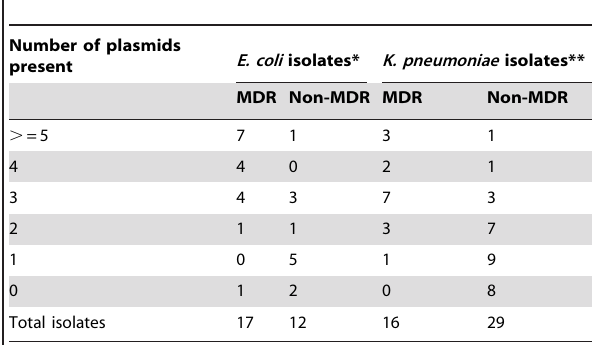
Table 1. Number of plasmids in MDR isolates compared with non-MDR